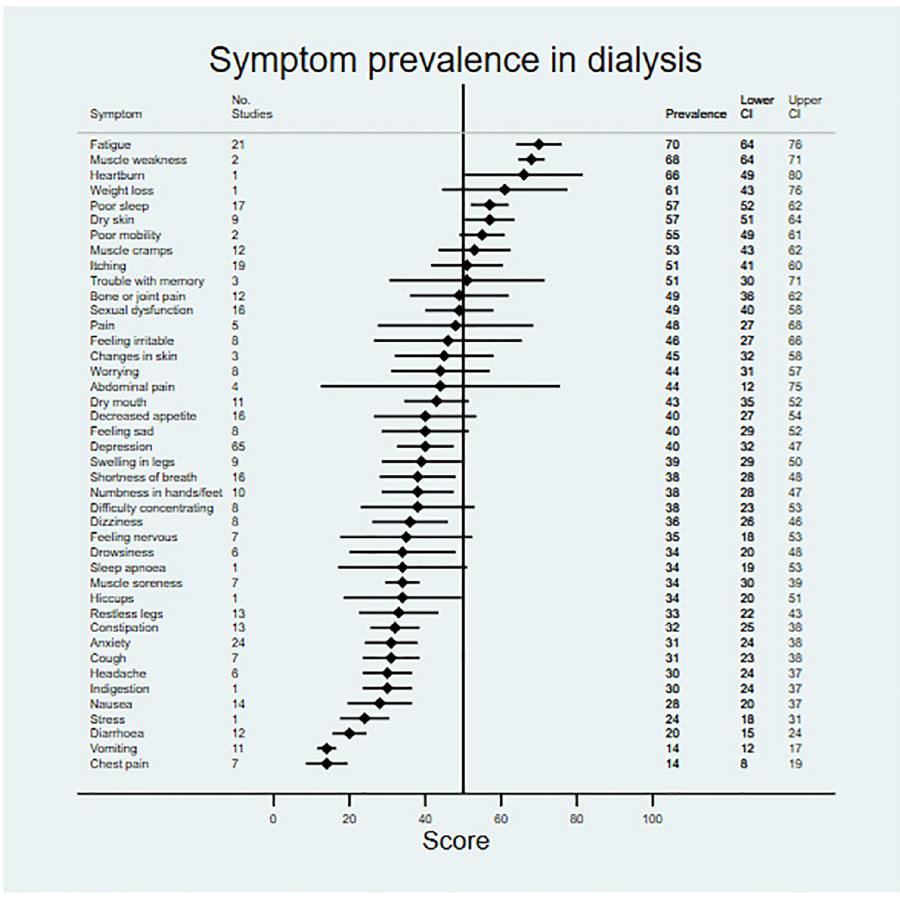
Fig 3. Pooled prevalence of patient-reported symptoms across included studies for patients on